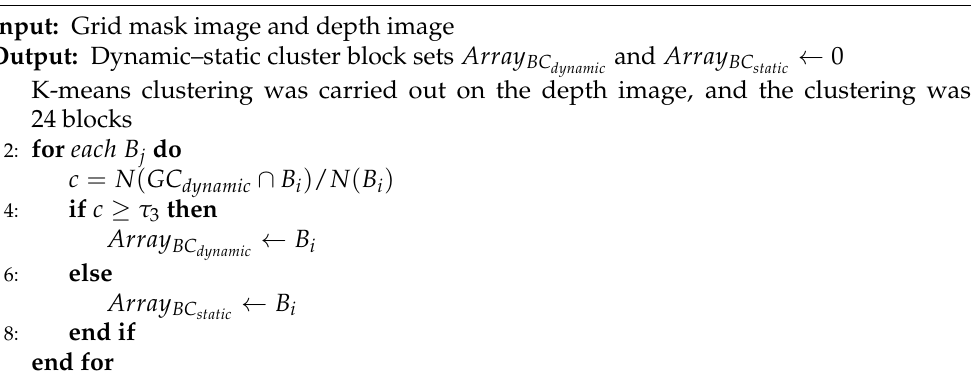
Algorithm 2 Dynamic–static K–means clusters